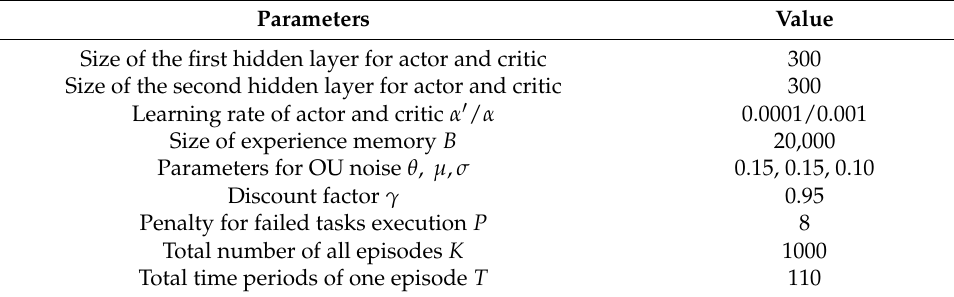
Table 2. Main hyperparameters of the